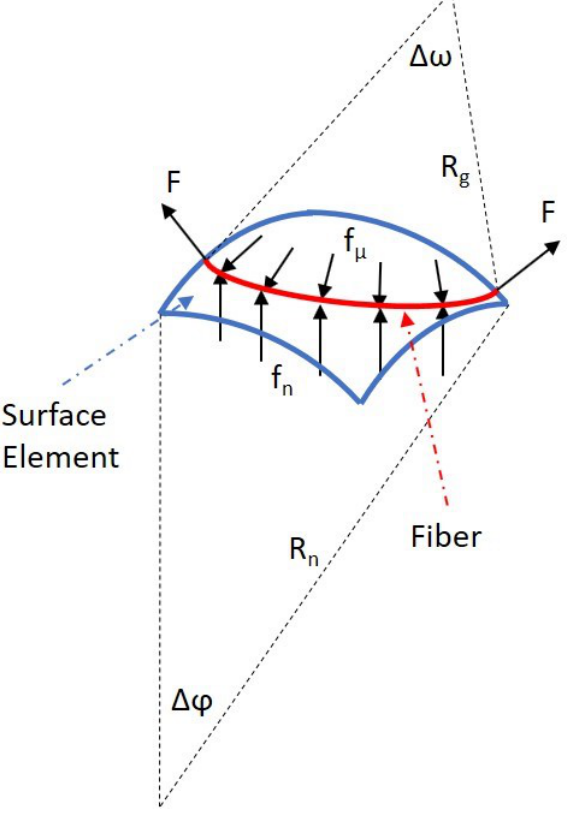
Figure 2. Forces acting on the fibre on an arbitrary